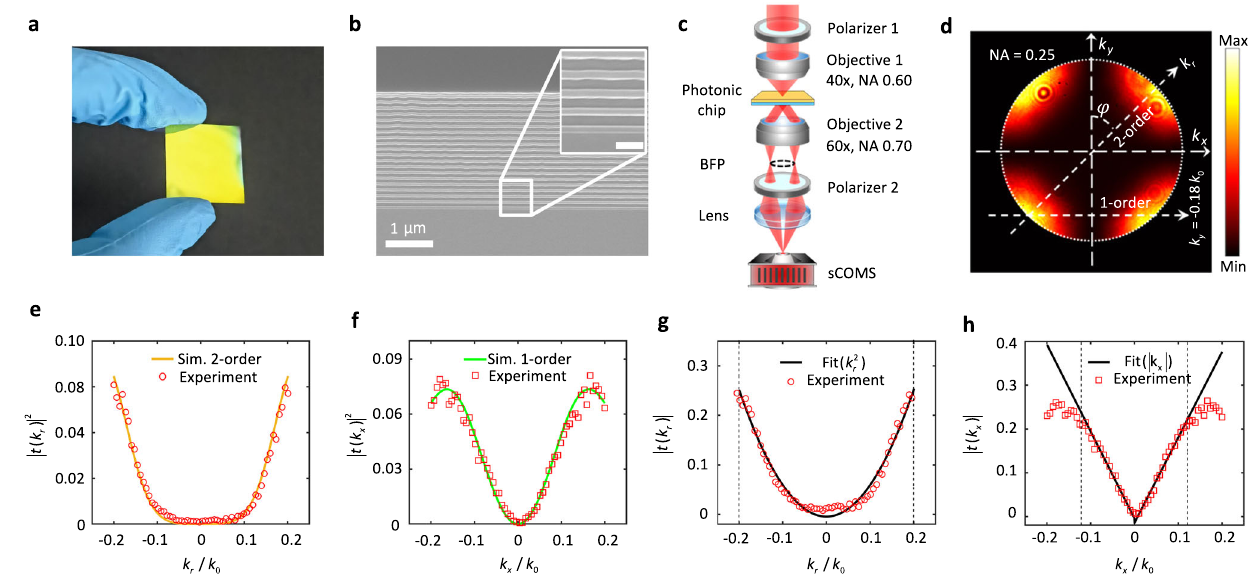
Fig. 2 | BFP imaging of the planar photonic chip, no specimens are placed on the chip. a Photograph of the fabricated planar photonic chip. b Cross-sectional SEM view of the photonic chip. c Schematic of the experimental setup used to perform BFP imaging. d Experimentally measured BFP image at λ = 643nm.